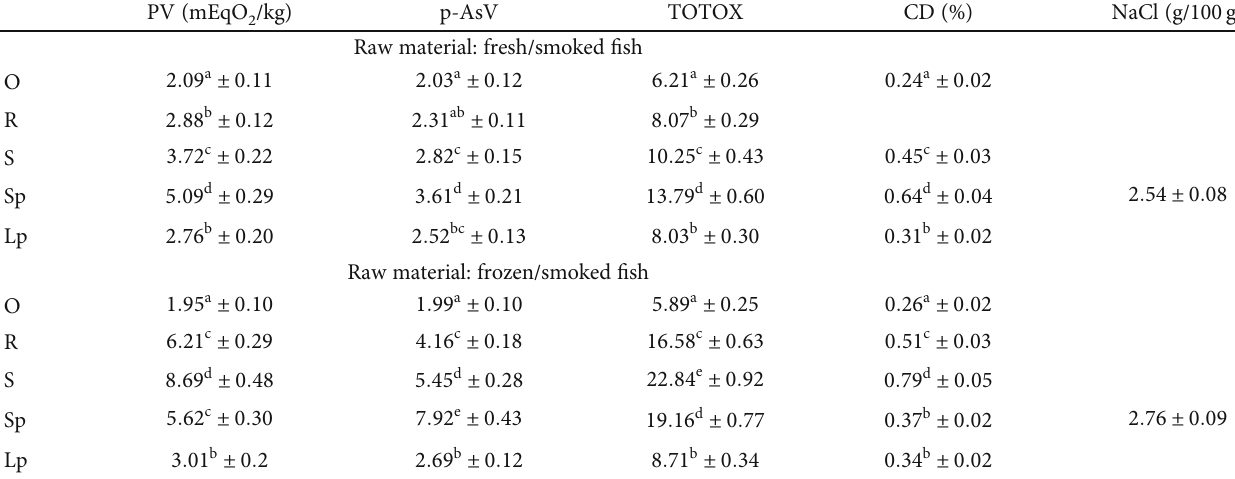
Table 5: Oxidation level (in the extracted lipids from oil, raw fi sh, smoked fi sh, and solid and liquid parts of canned fi sh) and salt content in solid parts of canned